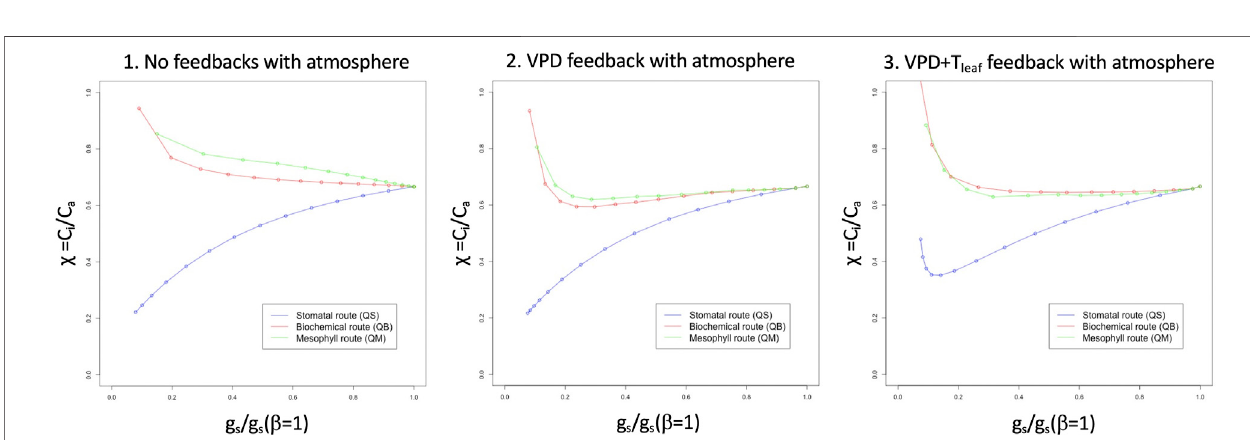
FIGURE2| IdealizedsolutionsprovidedbytheEgeaetal.(2011)model:relativestomatalconductance(g s /g s ( β (cid:1) 1), x axis)versusinternalCO 2 concentration,C i ( y axis,expressedas Eq.5 )forthethreepathwaysandforzerofeedbackwiththecanopyairenvironment(leftpanel),VPDfeedbackwiththecanopyairenvironment(center panel) and VPD plus leaf temperature feedback with the canopy air environment (right